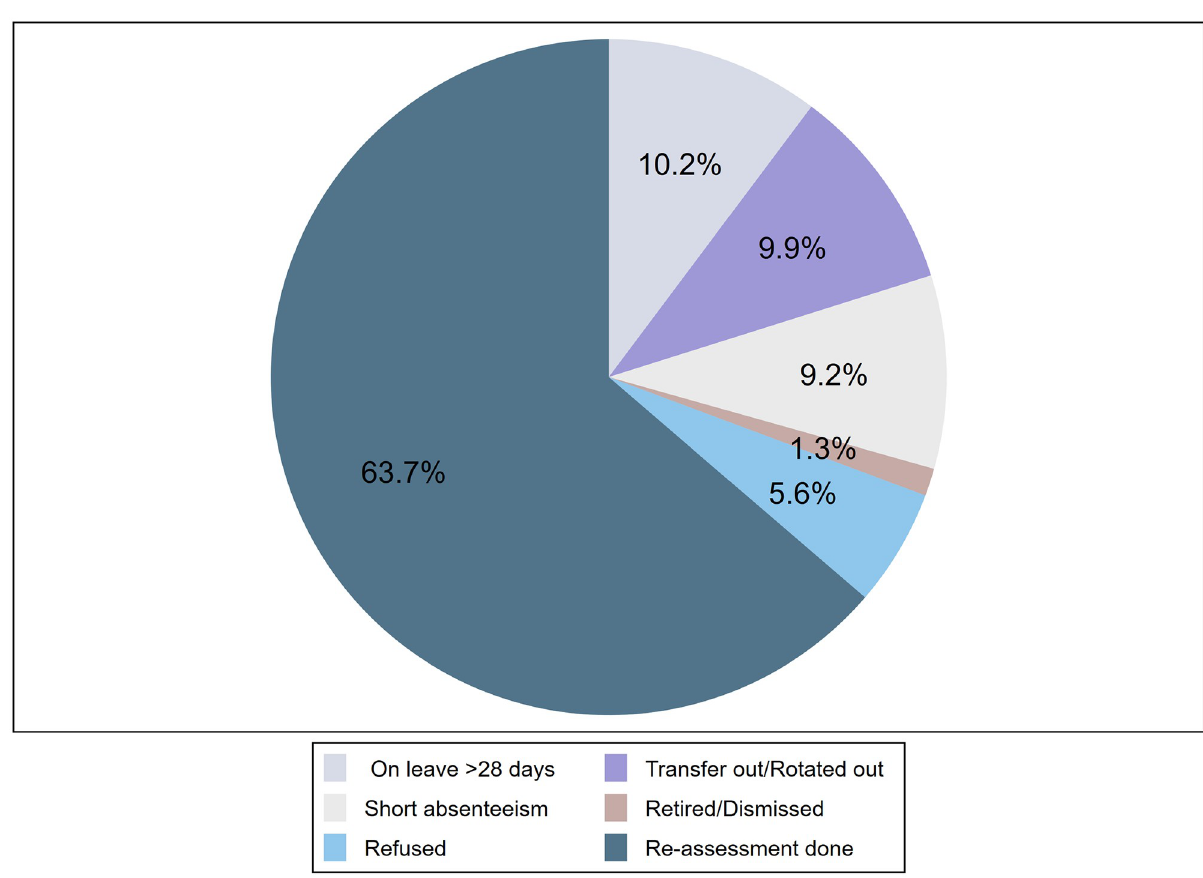
Fig 1. Availability of health workers within the facilities at 10-month follow-up (n = 303). A group pf 303 health workers were followed-up at 10-month after training, 63.7% (193/303), were available for re-assessment. The remaining 110 health workers were unavailable: 10.2% (31/303) were on annual, maternity or sick leave, 9.9% (30/303) were transferred/rotated out of maternity ward, 9.2% (28/303) were on short absenteeism attending training outside of facility, 5.6% (17/303) refused to be re-assessed and 1.3% (4/303) had left their profession: retired or dismissed.